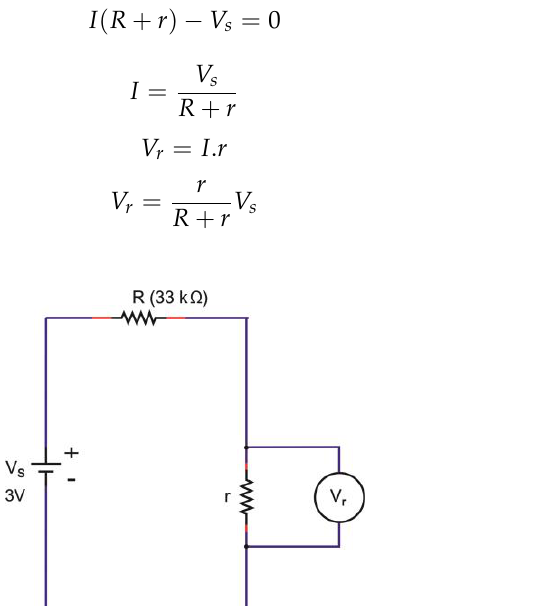
Figure 10. The hypothetical schematic circuit of the Orgacon ICP 1050-containing device with no capacitive behavior.